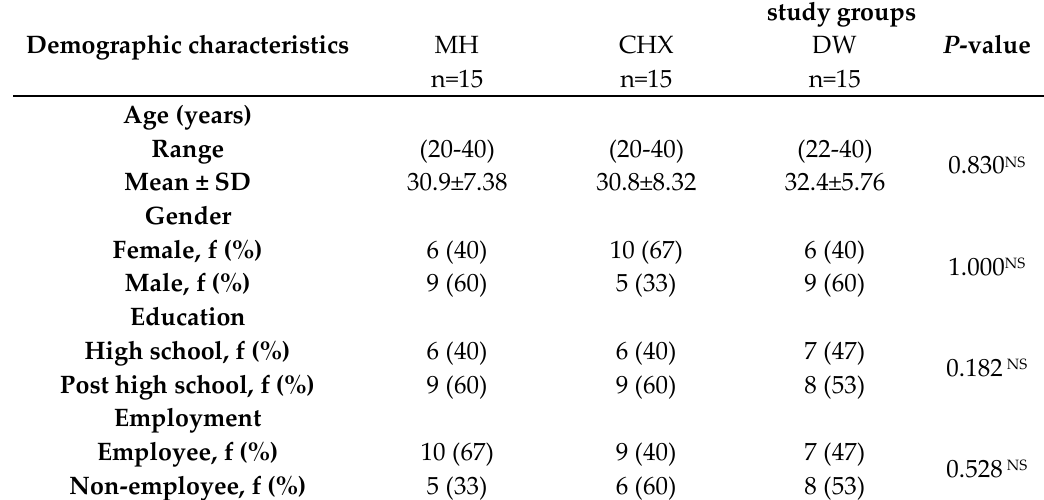
Table 1: Demographic characteristic of participants in three groups of the